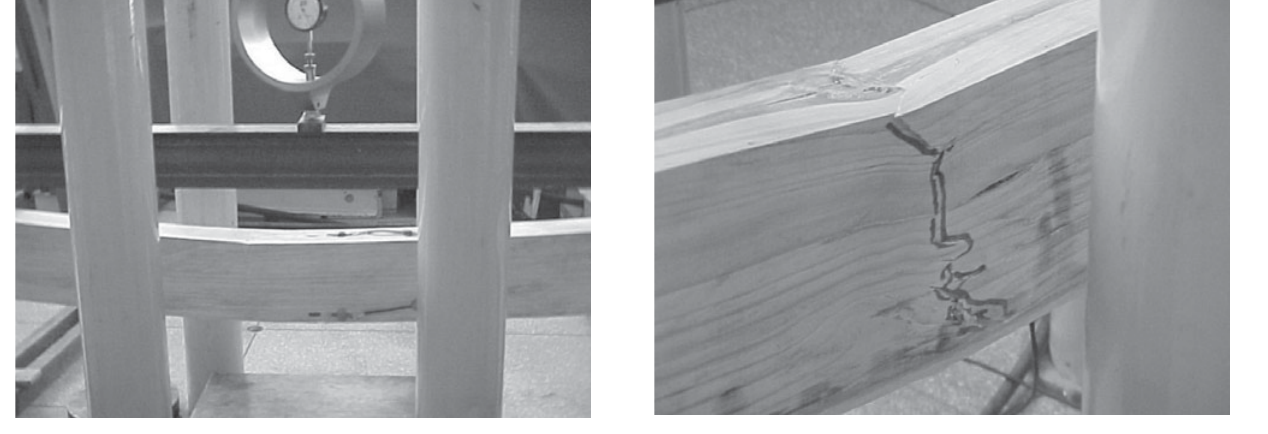
Figure 11. Deflection, followed by tensile failure of the beam.